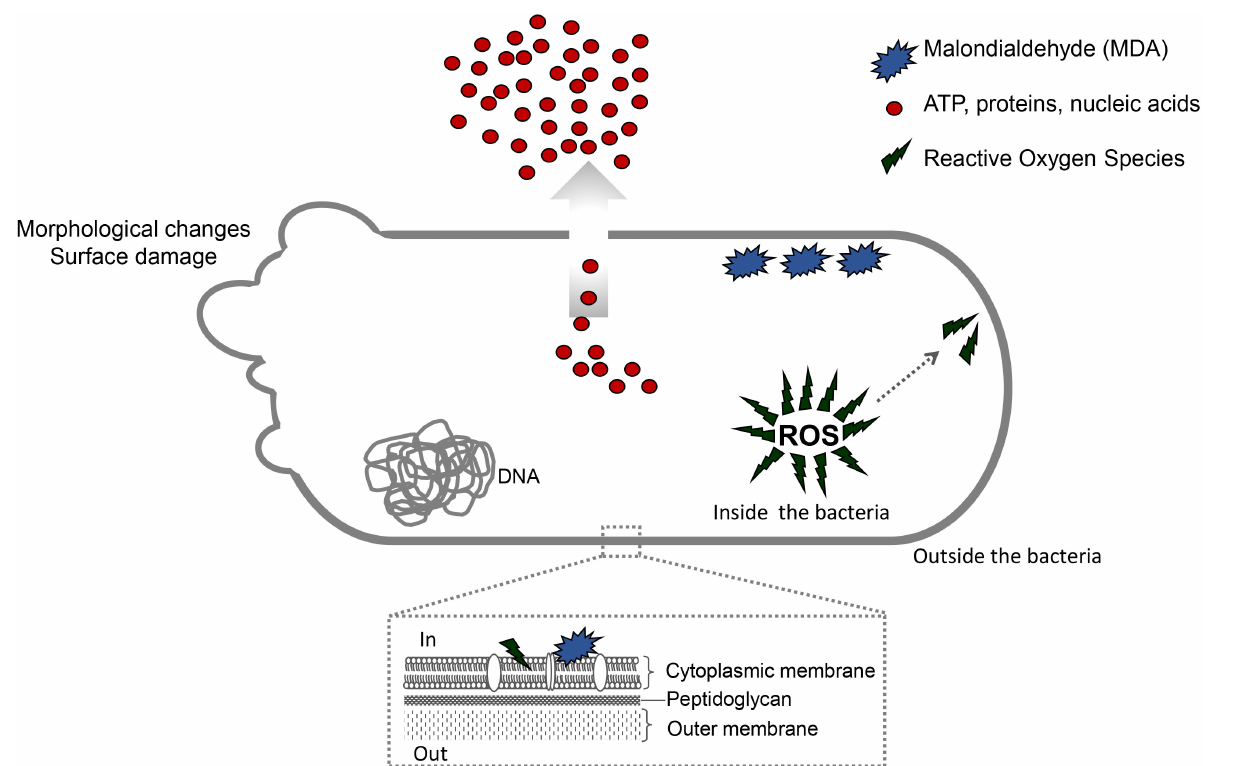
FIGURE 9 | Antibacterial mechanism of action of the bioAgNP and oregano derivatives, both alone and in combination. Oregano vulgare -derivatives, especially Thy, disturb the selective permeability of bacterial cell membrane, resulting in high leakage of cellular proteins, DNA, RNA, and ATP. Electron microscopy analysis shows they also cause physical damage in the cytoplasmic membrane and cell wall. The antibacterial mechanism of Thy also involves oxidative stress by enhancing intracellular reactive oxygen species and amount of MDA (marker of lipid peroxidation). The bioAgNP show multiple antibacterial mechanisms: ROS generation, lipid peroxidation, disruption of cytoplasmic membrane and cell wall, and loss of cytoplasmic content. The combination containing Thy and bioAgNP shows strategic antibacterial mechanism. Thy disturbs the selective permeability of the bacterial cell membrane and consequently facilitates access of nanoparticles to the bacterial cytoplasm. Thy plus bioAgNP causes loss of cytoplasmic content, physical damage in the membrane and wall cell, and oxidative stress.